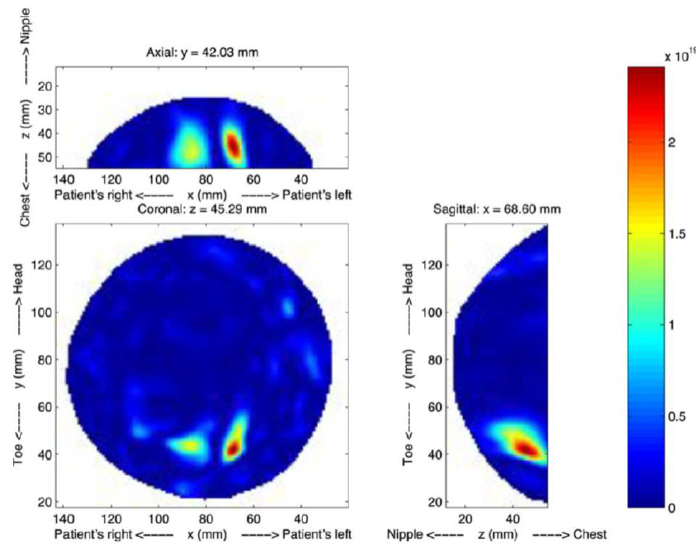
Figure 20. Reconstructed TSAR images using the system developed by Fear et al. [78]. Reprinted with permission from [78].